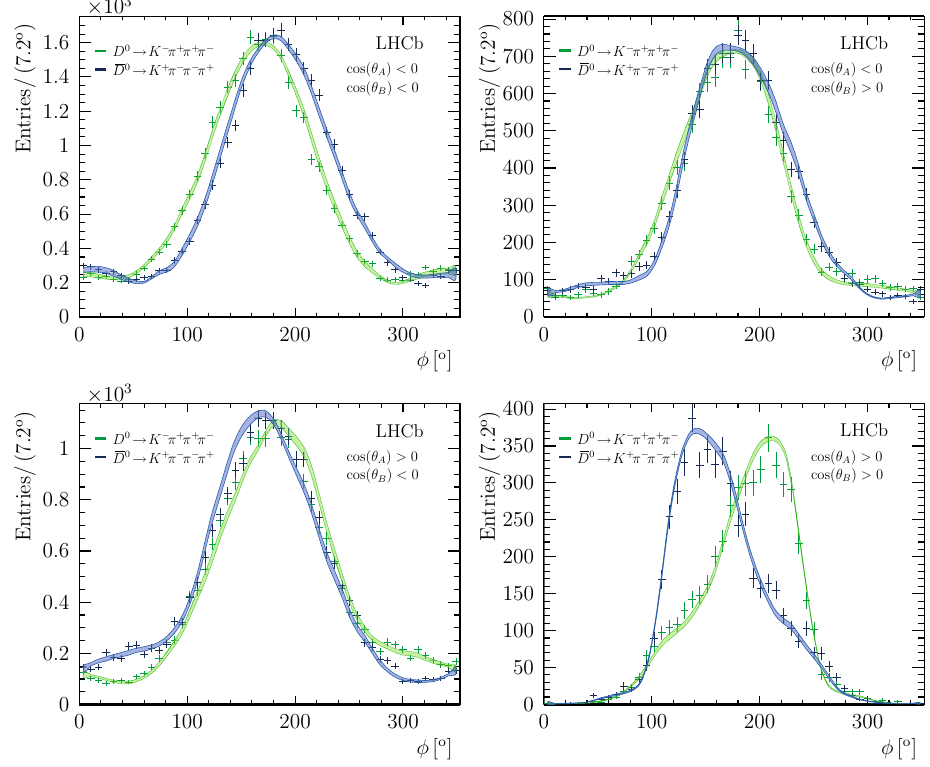
Fig. 4 Parity violating distributions for the RS decay in the K ∗ ( 892 ) 0 ρ( 770 ) 0 region defined by ± 35MeV( ± 100MeV) mass windows about the nominal K ∗ ( 892 ) 0 (ρ( 770 ) 0 ) masses. Bands show the predictions of the fitted model including systematic